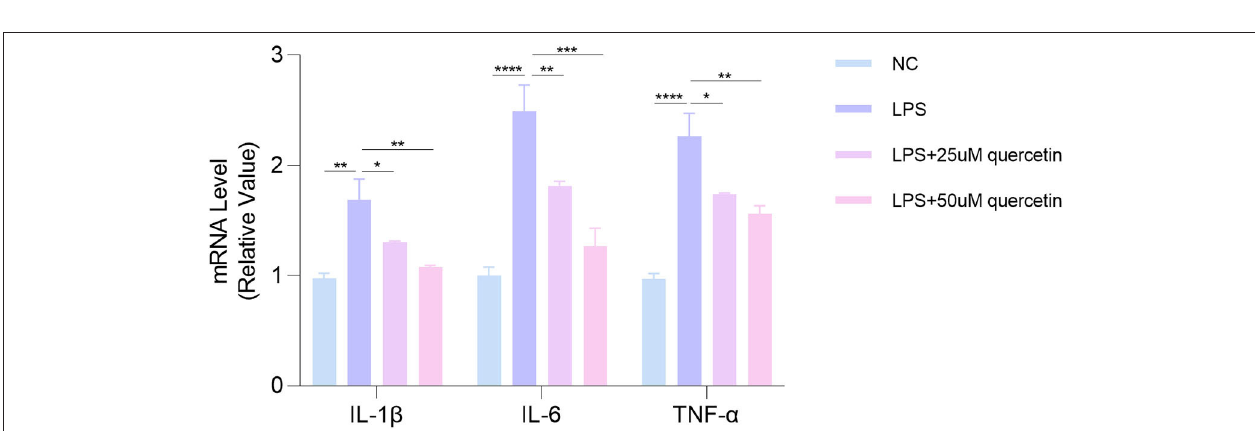
FIGURE 5 | Quercetin attenuates LPS-induced attachment of human umbilical vein endothelial cells (HUVECs). The messenger RNA (mRNA) levels of (A) intracellular adhesion molecule 1 (ICAM-1) and (B) vascular cell adhesion molecule 1 (VCAM-1). (C,D) The number of THP-1 cells attached to HUVECs. Data are listed as mean ± SD of at least three independent experiments. NC, negative control; LPS, lipopolysaccharide. * P < 0.05, ** P < 0.01, *** P < 0.001.